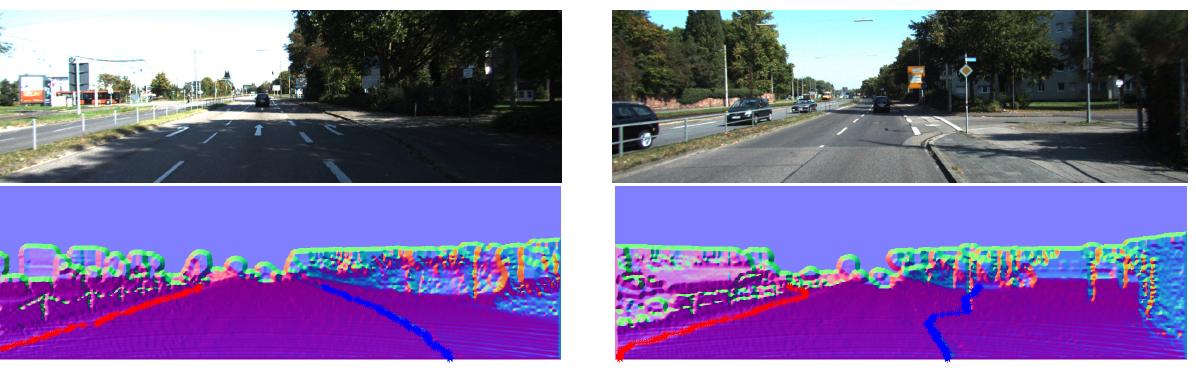
Figure 18. ( a ) Straight and curved curbs; ( b ) Long and short